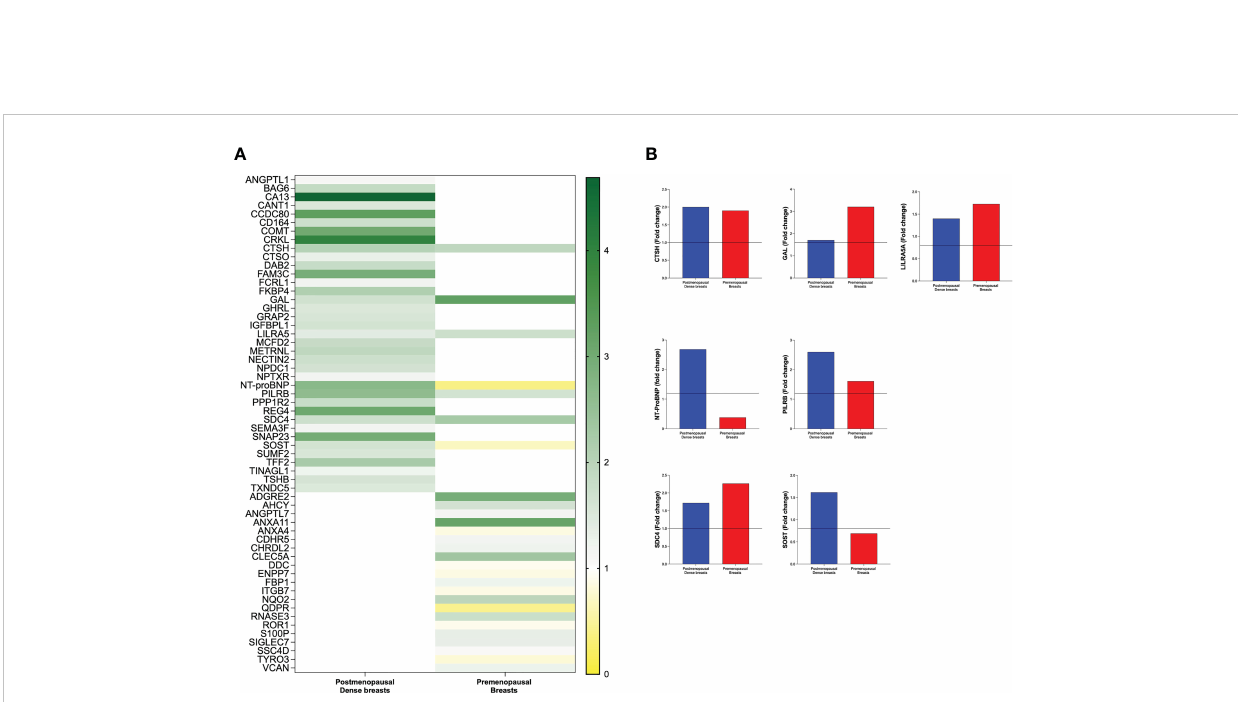
FIGURE 6 Distinct different patterns of expression levels of protein in dense breasts and premenopausal breasts. Microdialysis was performed for in vivo collection of proteins from the extracellular space that were quanti fi ed in as described in the Materials and Methods in 40 postmenopausal healthy women with dense (n=20) or nondense (n=20) breast tissue, and 19 premenopausal women investigated in the luteal phase of the menstrual cycle. (A) Left column depicts 37 proteins that were identi fi ed to be signi fi cantly altered in postmenopausal dense breast tissue vs. postmenopausal nondense breast and right column depicts the 28 proteins that were identi fi ed to be signi fi cantly altered in premenopausal breast tissue vs. postmenopausal dense breast tissue. (B) The seven that were signi fi cantly altered in both postmenopausal dense breasts vs. nondense breasts and in premenopausal breasts vs. postmenopausal dense breasts. Five proteins were up-regulated in both cohorts whereas two proteins were up-regulated in dense breasts and down-regulated in premenopausal